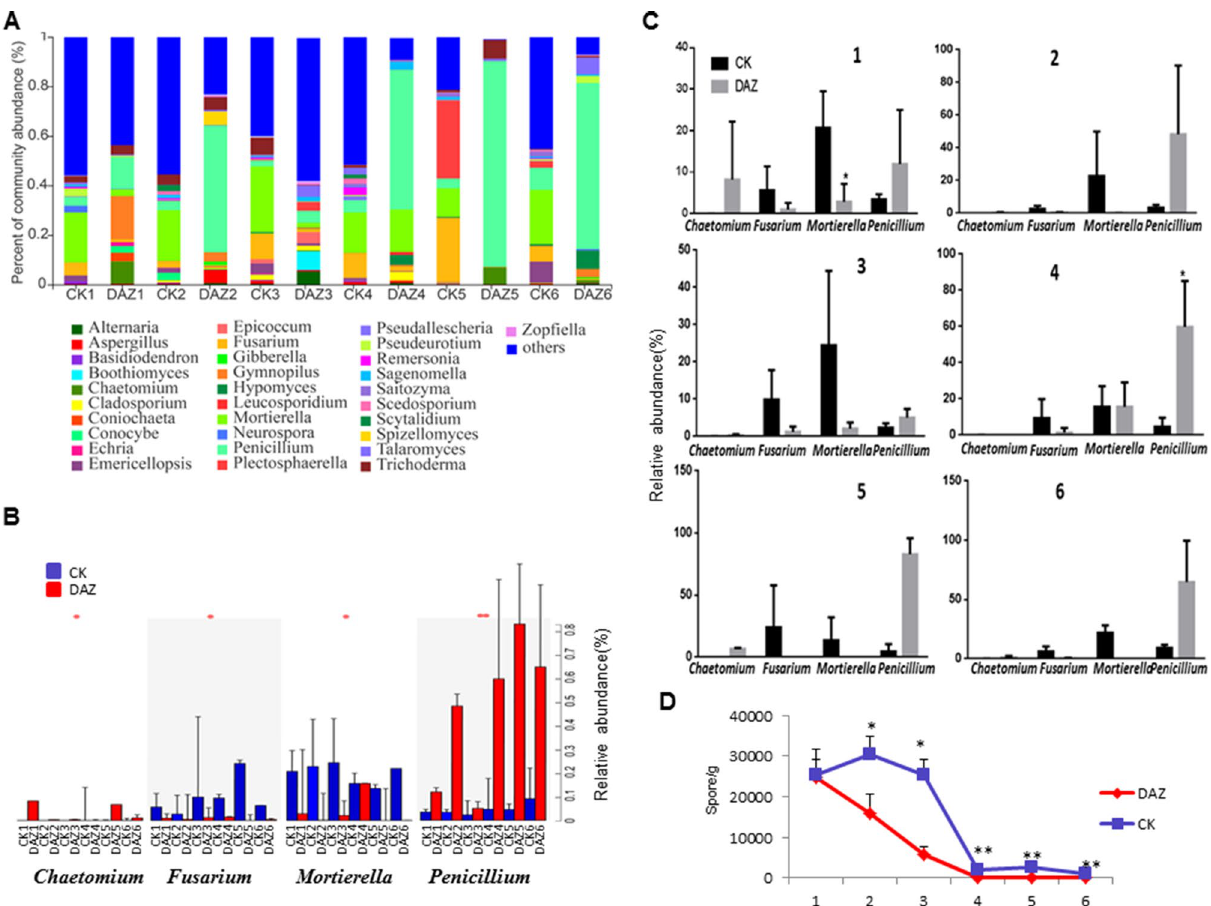
different sampling times. 1 (March 6th, 2018, before dazomet treatment), 2 (April 24th, 2018, watermelon seedling stage), 3 (May 3rd, 2018, Fusarium wilt symptom appearance), 4 (March 6th, 2019, before dazomet treatment), 5 (April 22th, 2019, watermelon seedling stage), 6 (April 29th, 2019, Fusarium wilt symptom appearance). Data are expressed as the means ± SD (n = 3). * 0.01 < P ≤ 0.05, ** 0.001 < P ≤